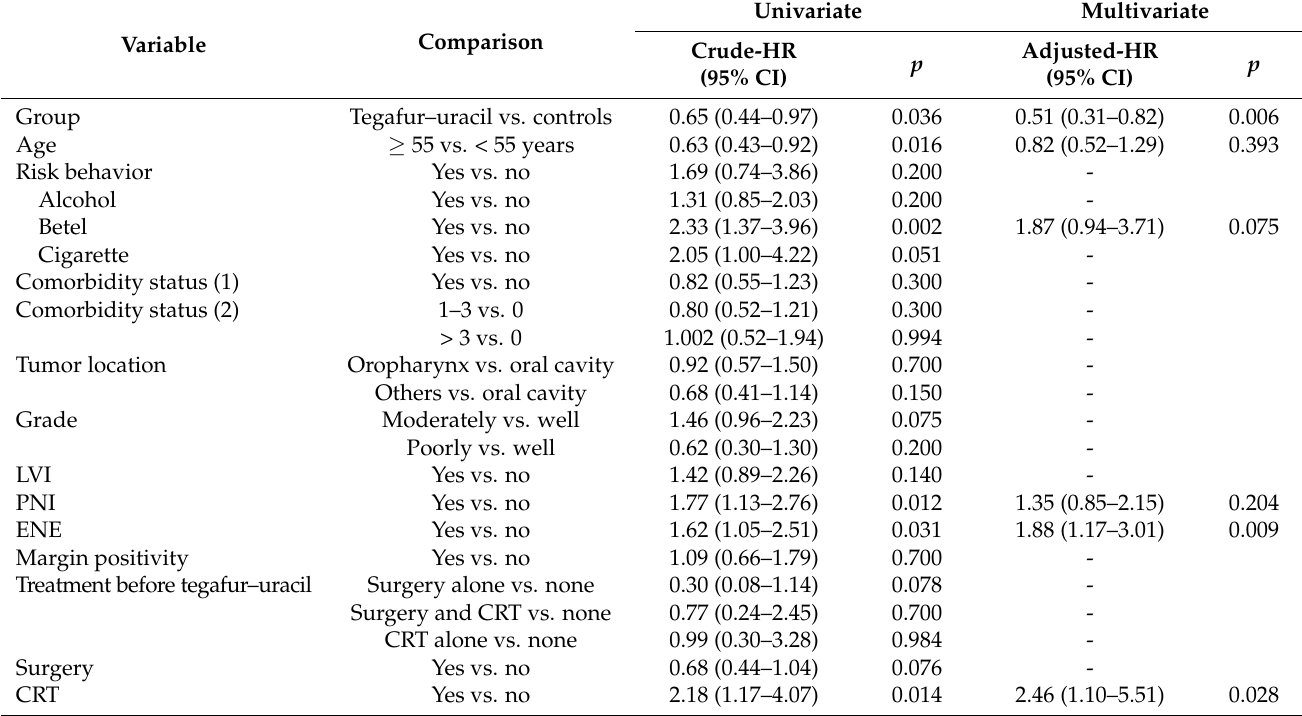
Table 4. Cox regression analysis for disease-free